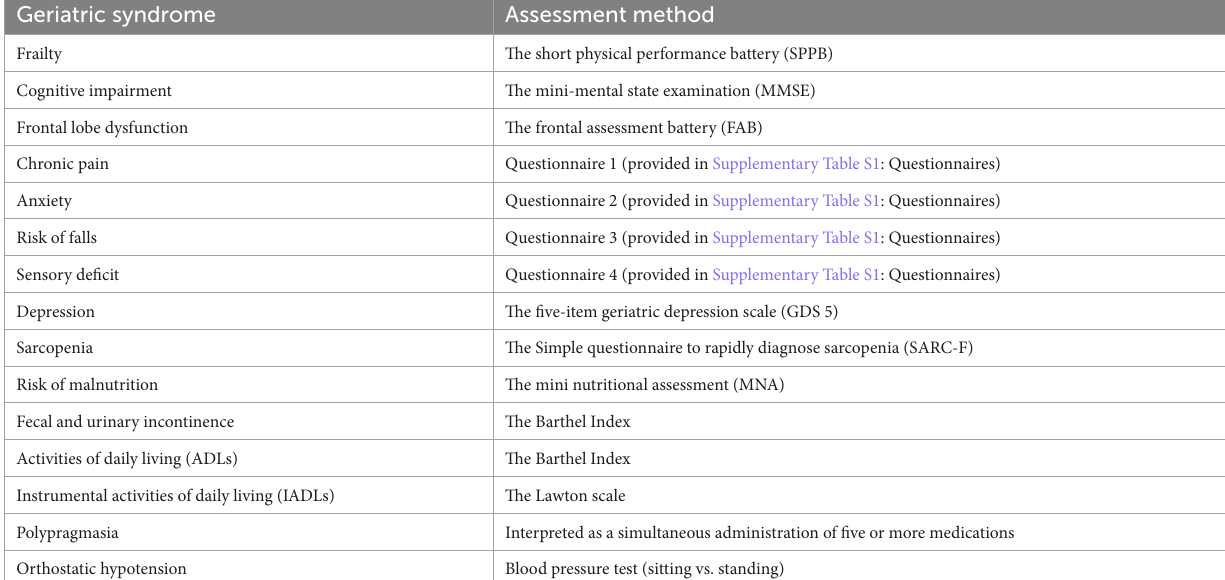
TABLE 1 Geriatric syndromes and methods of their